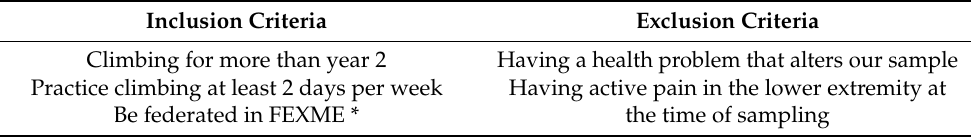
Table 1. Inclusion and exclusion